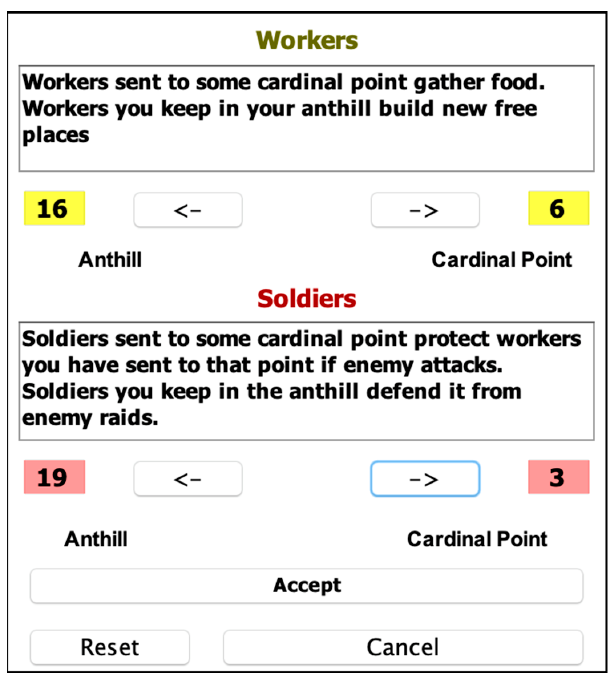
Figure A6. A window for sending workers and soldiers to the cardinal points.